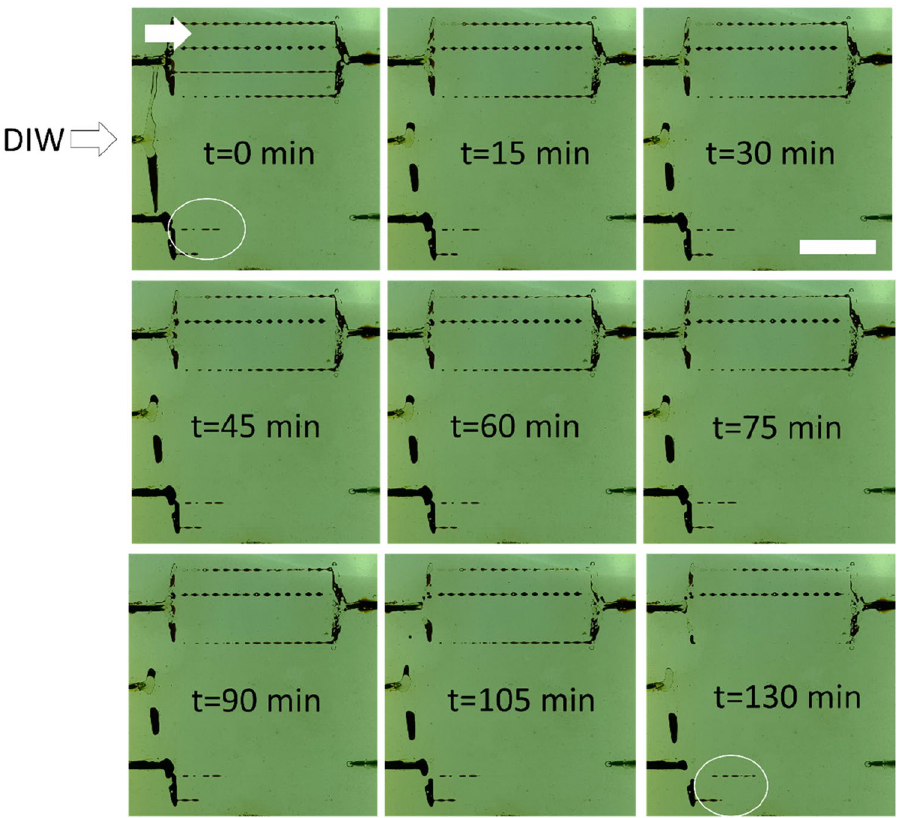
Figure 14. Macroscopic images of dual-patterned glass micromodel during injection of DIW for 2 PVs. The top and bottom porous media were initially saturated with crude oil and a solid gel formed from 3 wt% silica + 3 wt% NaCl in DIW after 24 h. The letter “t” shows the time of flooding. The white scale bar is 2 cm. The white arrow shows the flow